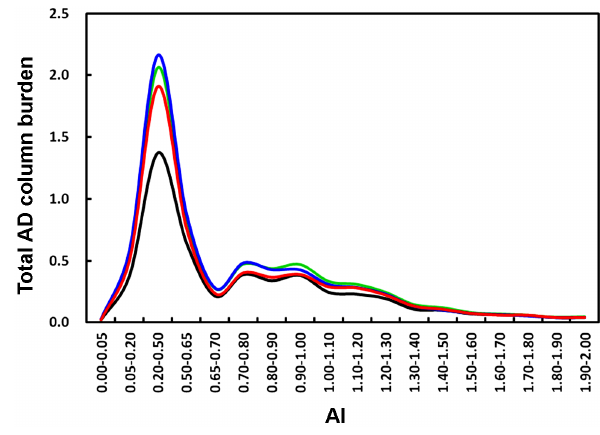
Figure 3. Comparison of the global anthropogenic dust (AD) col- umn burden (Tg) in spring (green), summer (blue), autumn (red), and winter (black) as a function of the climatological mean aridity index